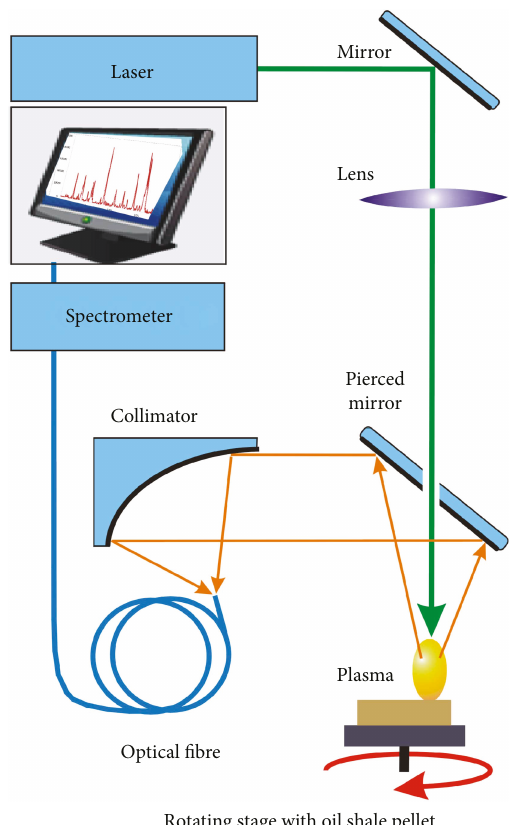
Figure 1: Sketch of the setup of measurements. Q-switched Nd:YAG laser YG980 and spectrometer Mechelle5000 were